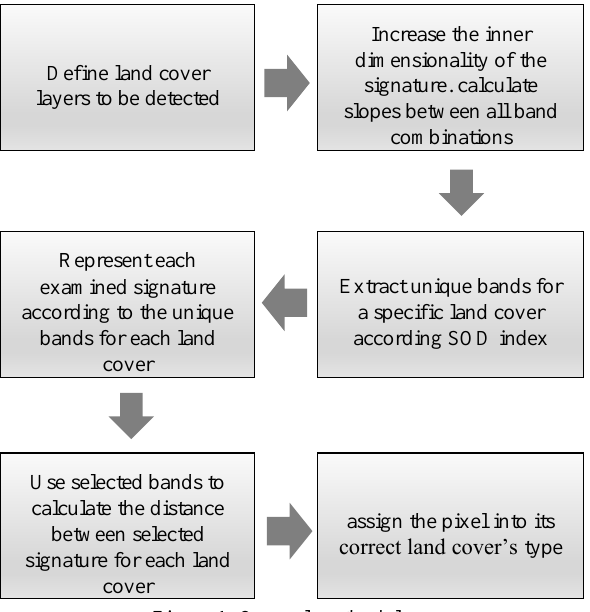
Figure 1. General